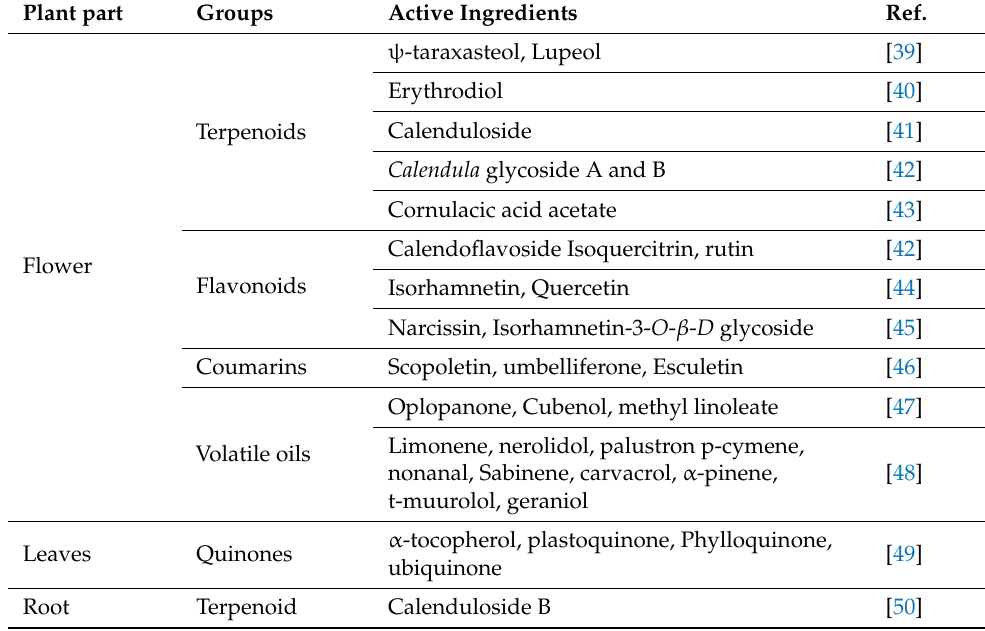
Table 2. Various chemical constituents are present in Calendula officinalis